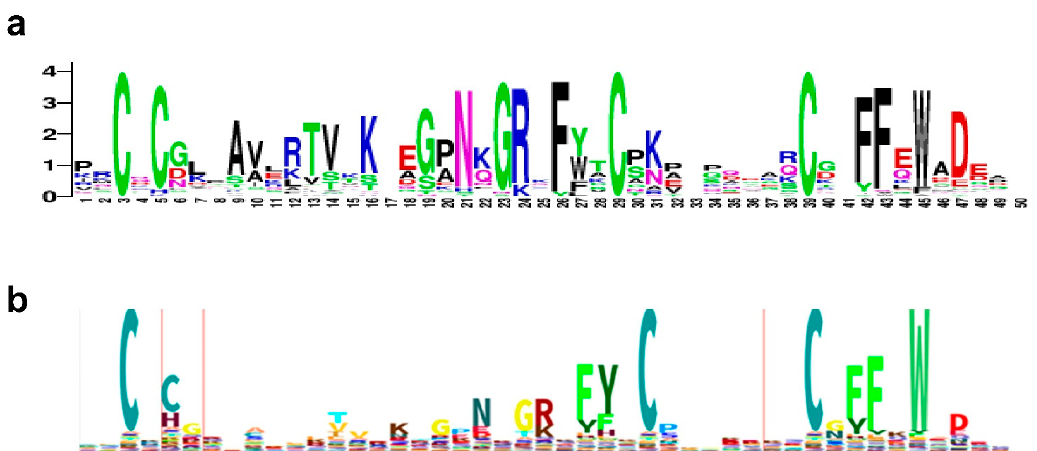
Figure 4. Comparison of consensus sequence for fungal Top3 zf-GRF from sequences of all zf-GRFs found in eukaryotes in the Pfam database. ( a ) Logo sequence for zf-GRF in fungal topoisomerase III (generated with WebLogo with 47 sequences from 27 species shown in Table S2). ( b ) HMM logo of all sequences in the Pfam database for zf-GRF (PF06839, sequences from 1341 species).